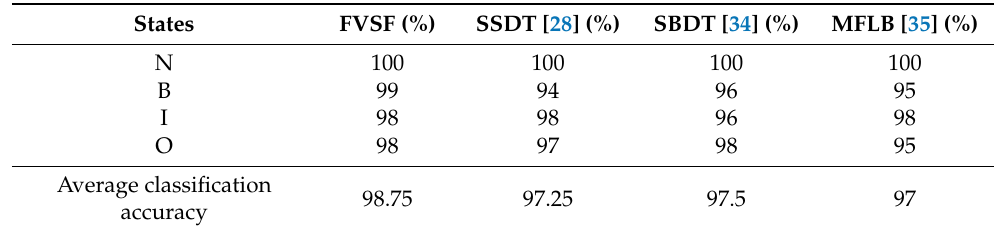
Table 7. Comparison of the proposed FVSF, SSDT [29], SBDT [35], and MFLB [36] for bearing data